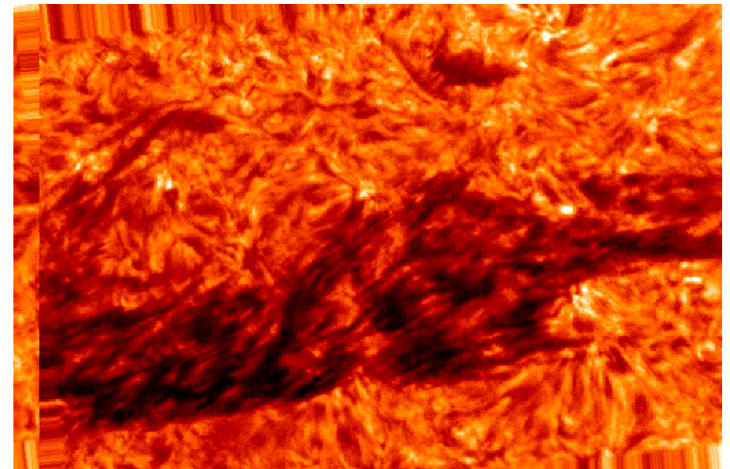
Fig.28 StillfromamovieshowingH α linecentreimagesofaquiescentfilamentobservedwiththeSwedish SolarTelescopeinLaPalma.Thesmall-scalestructuresdisplaythecharacteristicfilamentcounter-streaming motionsandundergosimultaneoustransverseoscillations,detectedasperiodicDopplervariations(fromLin etal.2003).(Towatchthemovie,pleasegototheonlineversionofthisreviewarticleatdoi:10.1007/s41116-